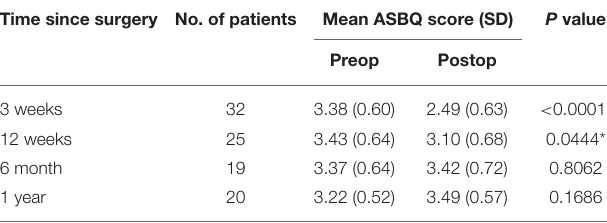
TABLE 2 | Overall postoperative ASBQ scores in patients who underwent endoscopic nasopharyngectomy. Time since surgery No. of